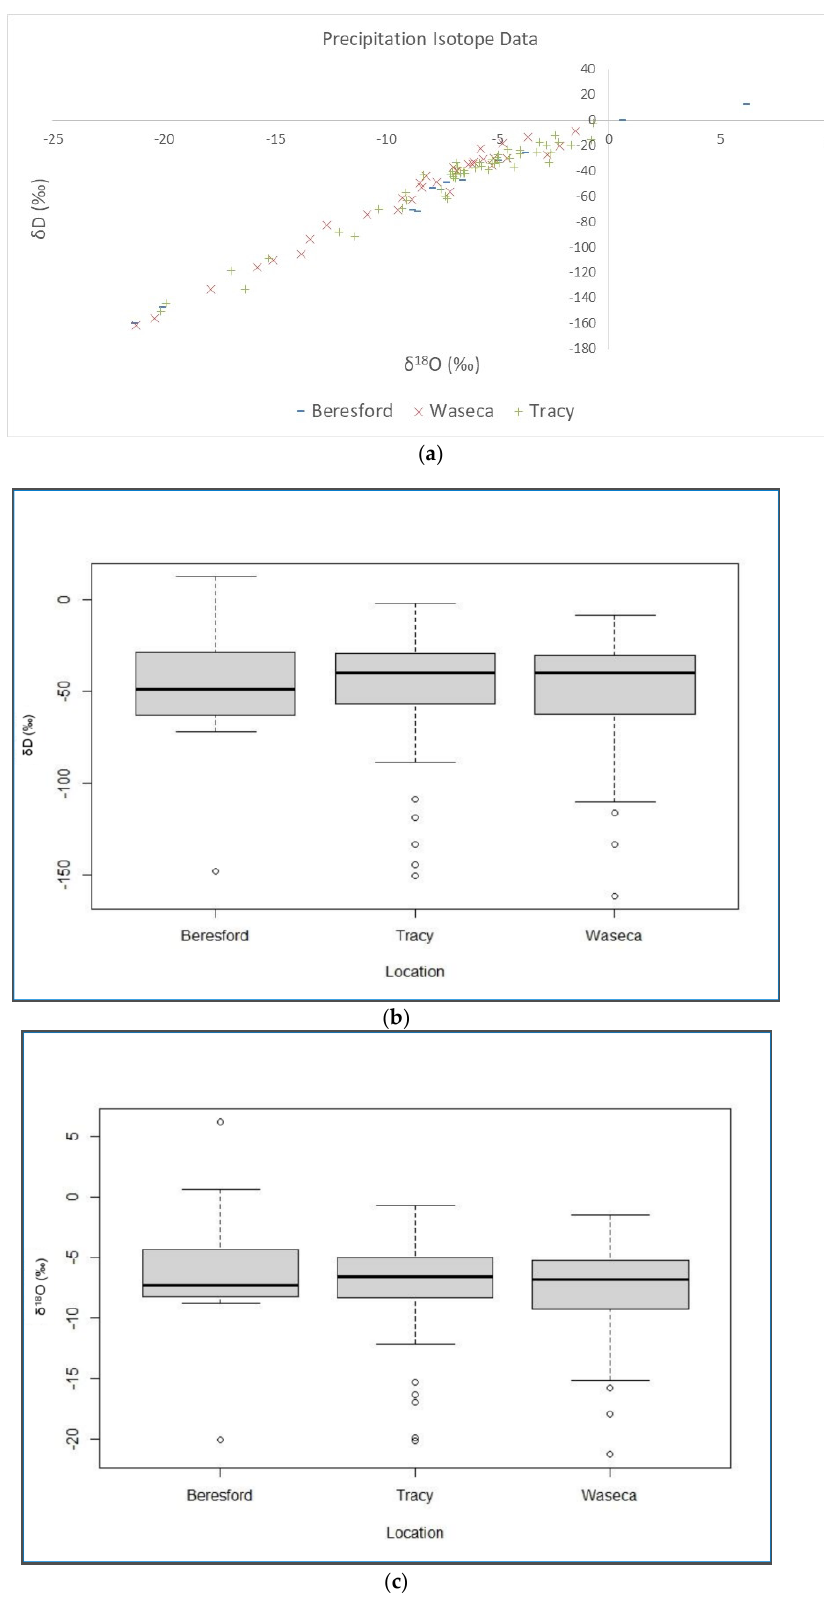
Figure 3. Precipitation isotopic signature plots. ( a ) Isotopic signature plots in 2016–2017 from Beresford, Tracy, and Waseca; ( b ) Boxplot for Delta D from three site using 2016 and 2017 daily precipitation data; ( c ) Boxplot for Delta O18 from three site using 2016 and 2017 daily precipitation data .